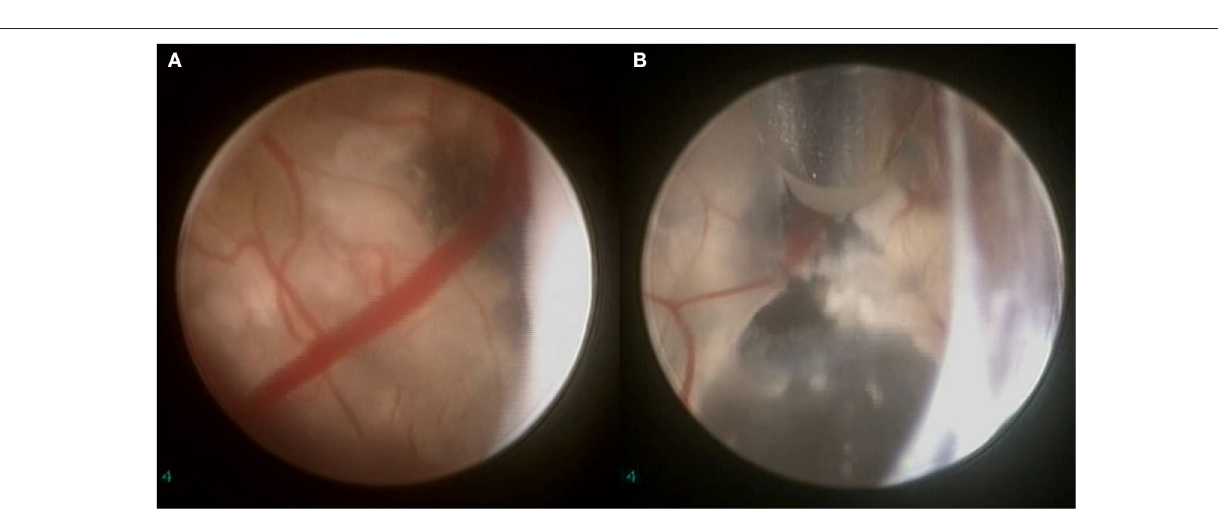
FIGURE 5 | Intraoperative endoscopic view of a cystic intraventricular craniopharyngioma in a 6-year-old child. (A) Craniopharyngioma cyst wall (with calcifications) visualized. (B) Using bipolar diathermy, a fenestration is made into the cyst wall for draining its contents and insertion of a ventricular catheter connected to an Ommaya reservoir (through which alpha-interferon was